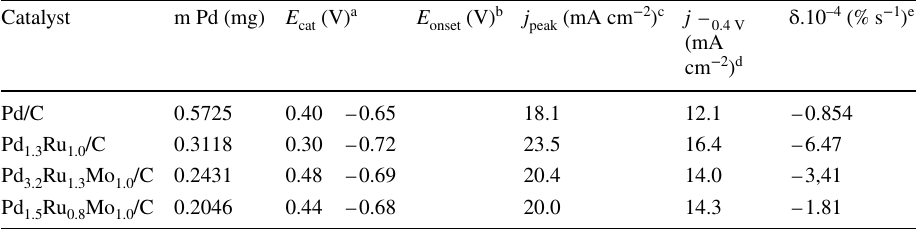
a Peaks of cathodic potentials, E b EOR initiation potential, E c Maximum current density, j d Poisoning rate, δ